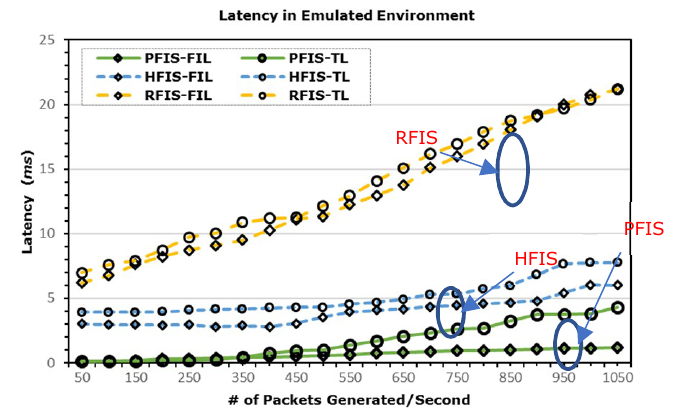
Figure 7. Network setup in Mininet.